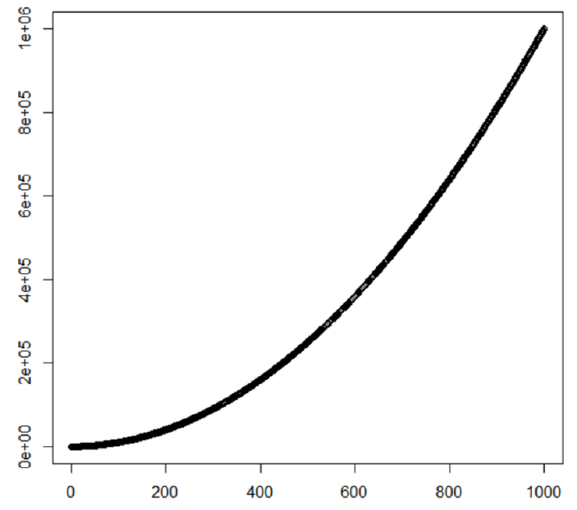
Figure 14. Greedy algorithm: Worst’ graph Using R Studio. (X axis: Number of nodes, Y axis: Amount of calculation).